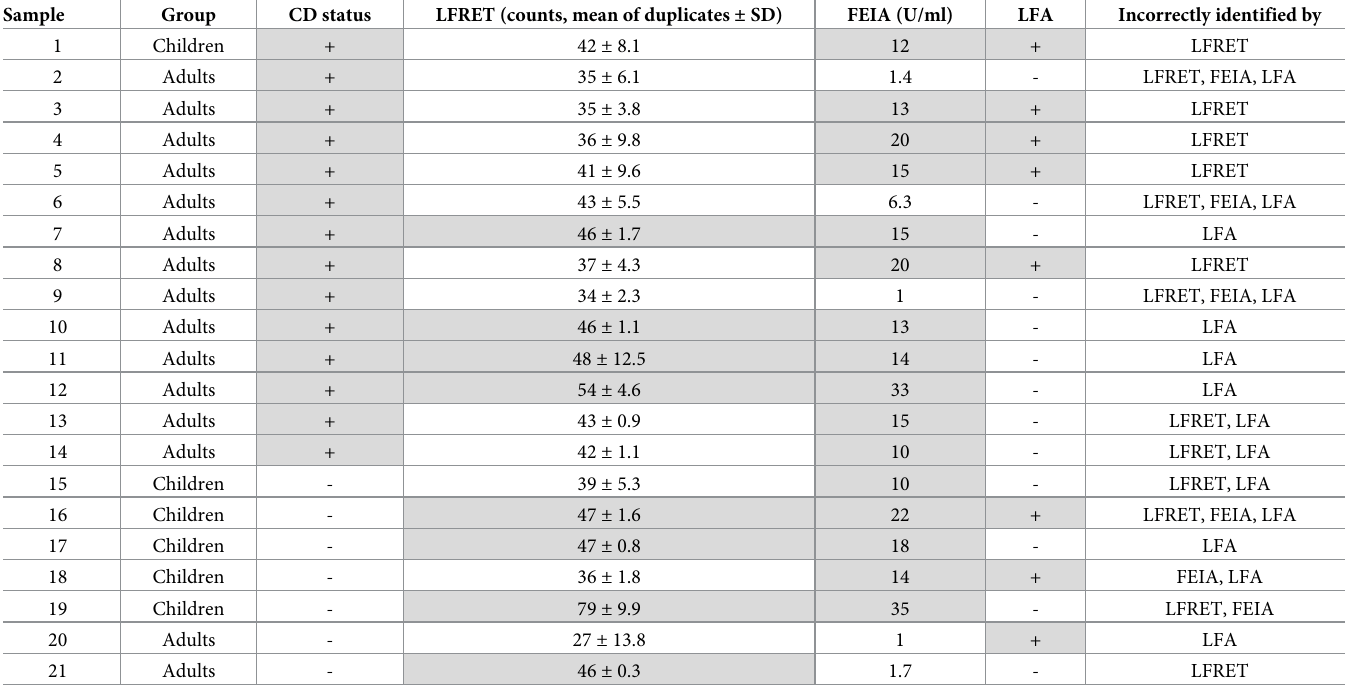
Table 2. Samples identified incorrectly by any of the methods